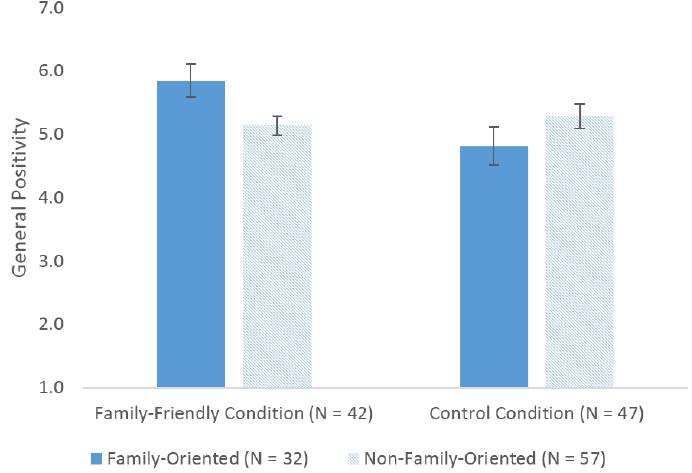
Figure 2. Positivity toward STEM careers by family orientation and condition.